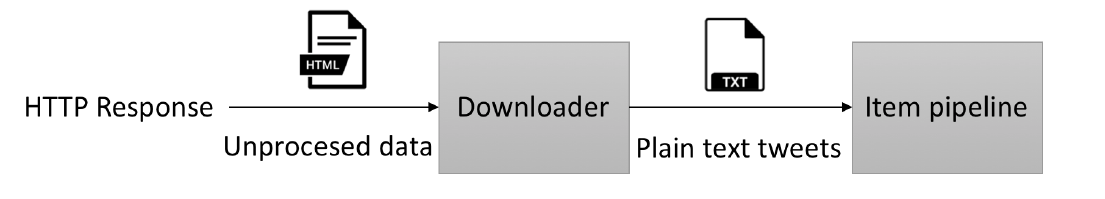
Figure 3. Embedded text in HTML.